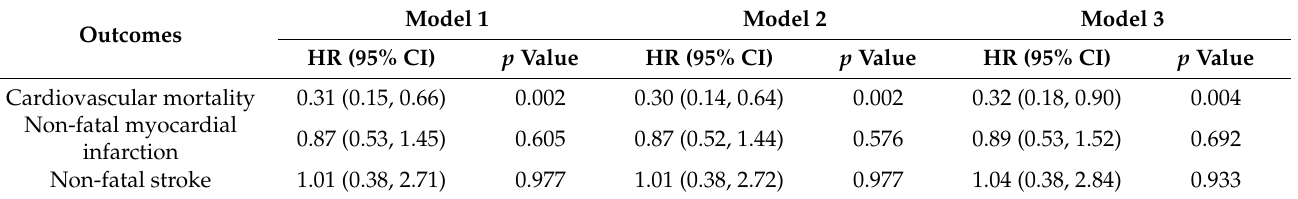
Table 3. Risk of primary outcomes for patients on ARB compared with those without